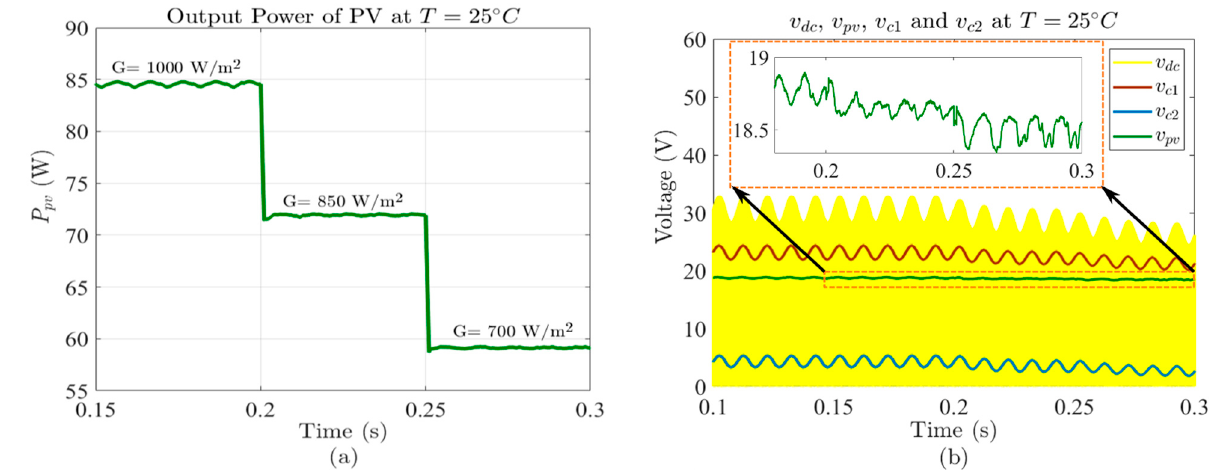
Figure 10. The simulation results of ( a ) 𝑃 (cid:3043)(cid:3049) and ( b ) 𝑣 (cid:3043)(cid:3049) , 𝑣 (cid:3031)(cid:3030) , 𝑣 (cid:3030)(cid:2869) , and 𝑣 (cid:3030)(cid:2870) under changing irradi- ance.